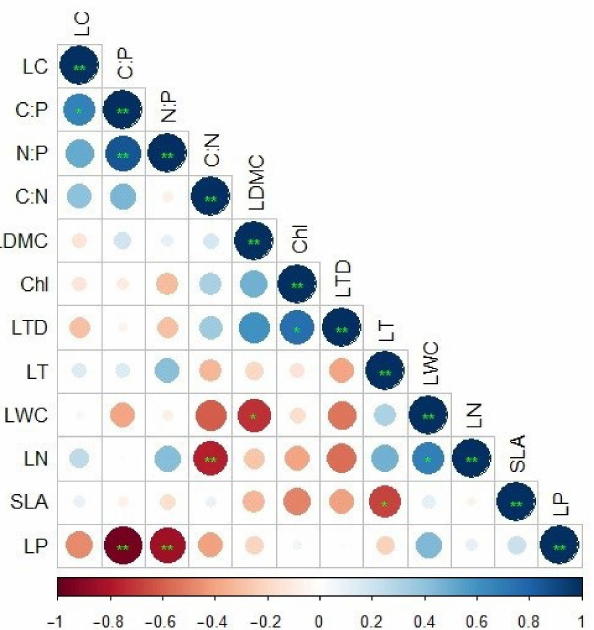
Figure 4. Correlation analysis of the leaf functional traits of Z. planispinum . LT, leaf thickness;